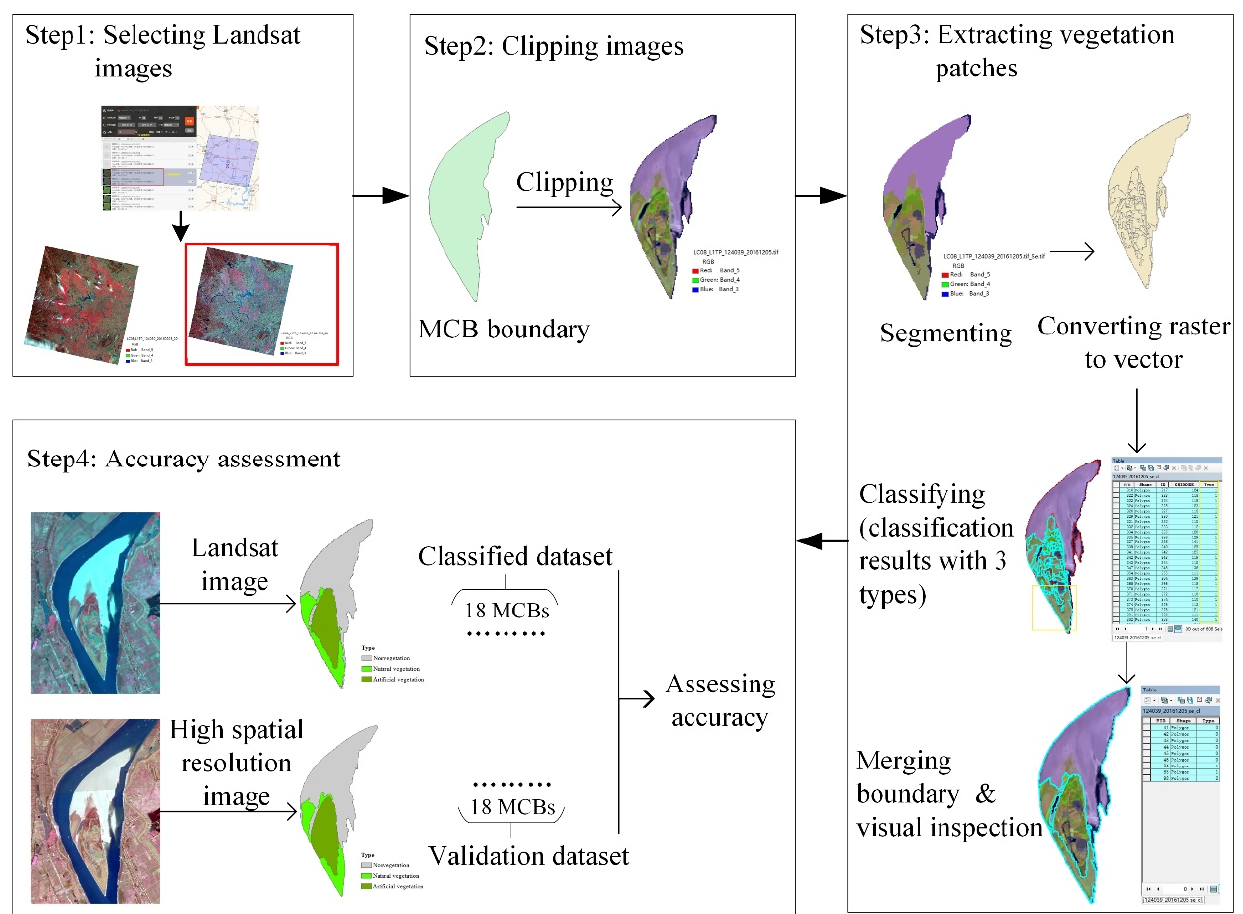
Figure 2. Workflow for extracting vegetation patches.